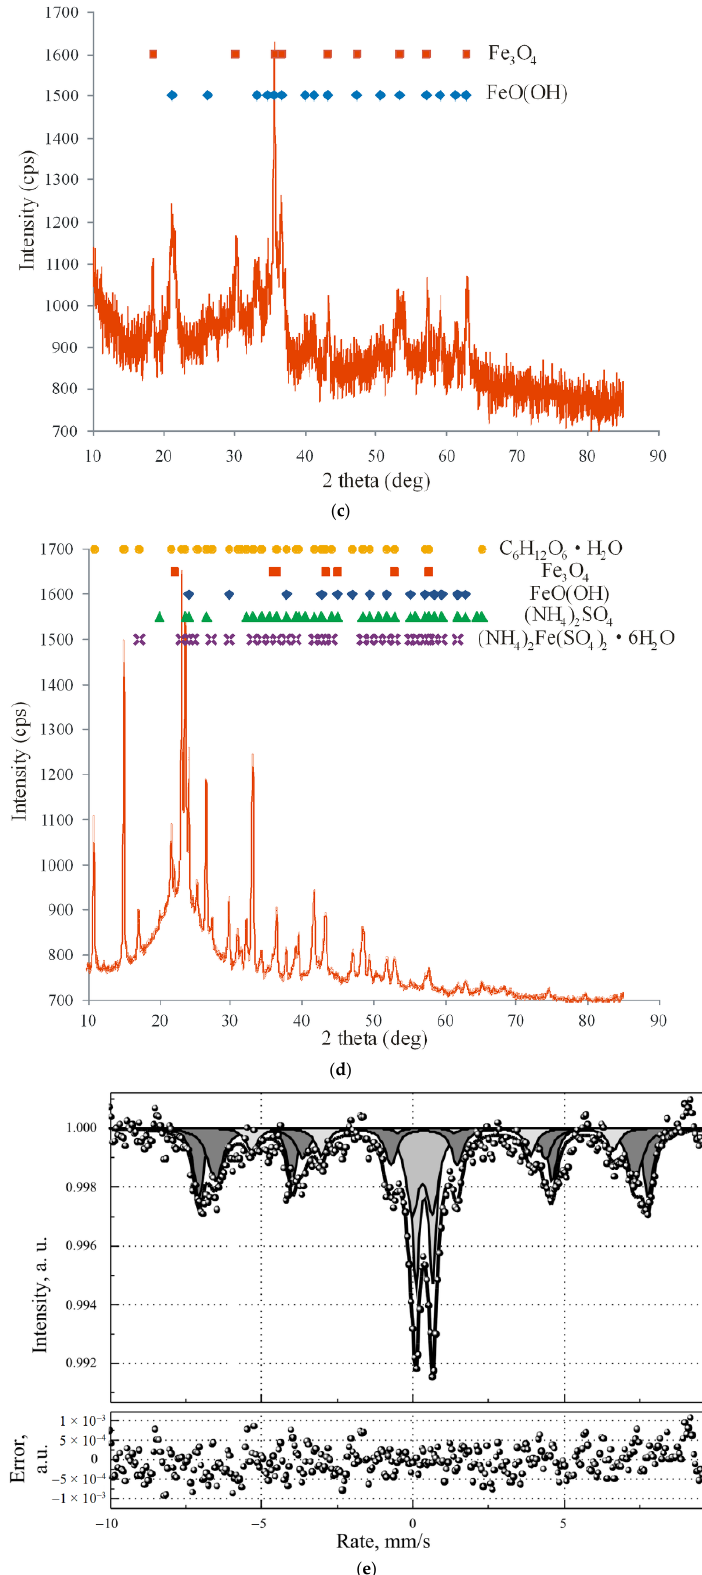
Figure 3. Magnetic properties and composition of MLPSICG: ( a,b ) magnetization reversal curves of MLPSICG; ( a ) full scale; ( b ) in the zone of small fields; ( c ) X-ray phase analysis of samples of MNP; ( d ) X-ray phase analysis of MLPSICG; ( e ) Mössbauer spectra of a sample of MLPSICG. The X-ray diffraction pattern of the MLPSICG shows the presence of magnetite [Fe 3 O 4 ] and goethite [FeO(OH)], as well as the initial magnetic nanoparticles that were used in the synthesis of MLPSICG (Figure 3c). At the same time, the X-ray pattern also contains a crystalline phase of glucose, which was used as a cryoprotectant for sample lyophilization, and the more complex compounds of maskagnit [(NH 4 ) 2 SO 4 ] and morite [(NH 4 ) 2 Fe(SO 4 ) 2 × 6H 2 O], which are by-products from the synthesis (Figure 3d). Among all the phases detected, only magnetite is magnetic. These by-products were not removed due to the difficulty of their removal when combined with phospholipids compared with when they are combined with pure magnetite nanoparticle. To quantitatively determine the phases of iron compounds in the MLPSICG, Möss- bauer spectra were obtained (Figure 3e). The results of spectral analysis and decomposi- tion into subspectra are shown in Table 1. Table 1. Results of processing MLPSICG Mössbauer spectra. N